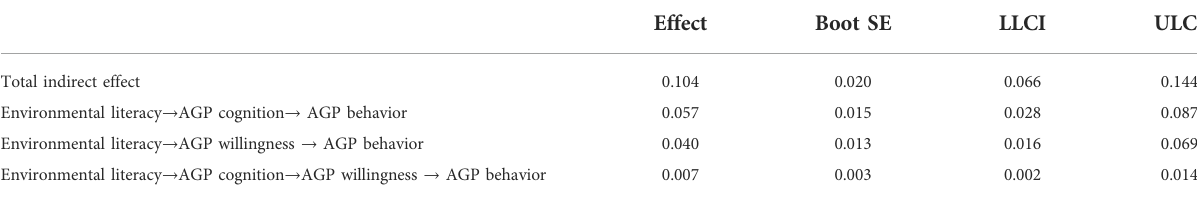
TABLE 11 The chain mediation effect of AGP cognition and AGP willingness (Bootstrap CI).